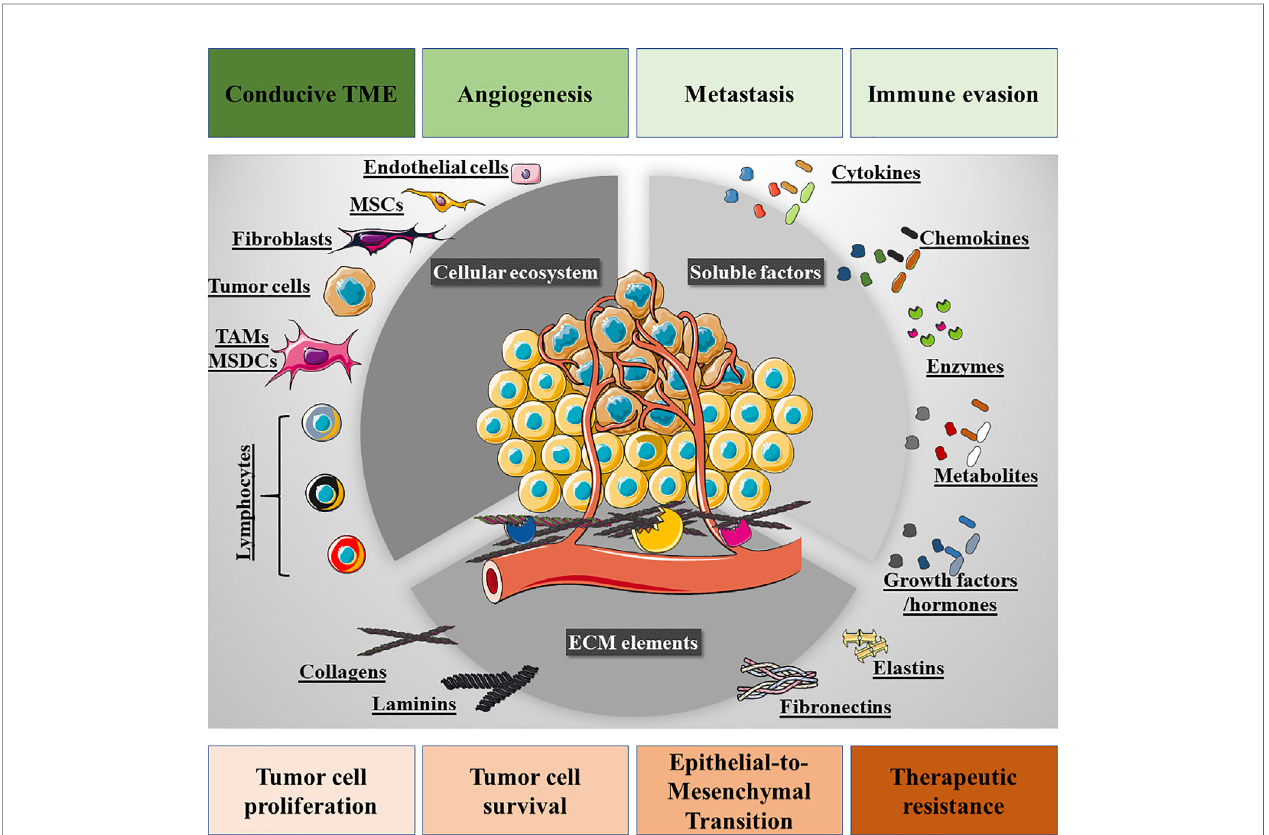
FIGURE 1 | Overview of the tumor microenvironment (TME). Three ecosystems contribute to the TME: fi rstly, the cellular ecosystem that is composed of immune cells (lymphoid and myeloid), fi broblasts, mesenchymal stem cells (MSCs), pericytes, endothelial cells, and tumor cells. Secondly, the cell-to-cell membrane interactions and soluble secreted factors that participate in the intricate interplay among these cells, e.g. , cytokines, chemokines, growth factors, hormones, proteolytic enzymes, and metabolites. Thirdly, the extracellular matrix (ECM) bed on which the cellular ecosystem resides, also providing biological signals to the tumor and stromal cells through ECM-derived peptides and the structural domains of its proteins. The interplay of these signaling networks and ecosystems promotes tumor cell proliferation, survival, epithelial-to-mesenchymal transition, drug resistance and loco-regional modulation, such that the TME is conducive to tumor cell invasion and metastatic spreading, angiogenesis and immune cell